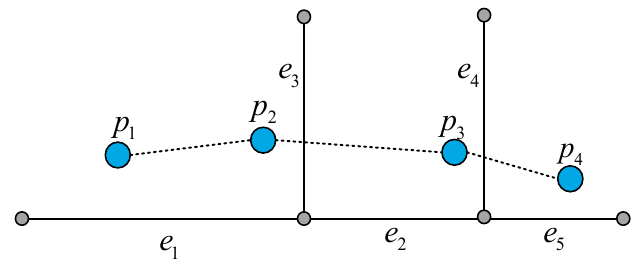
Figure 5. Disadvantages of matching only by spatial